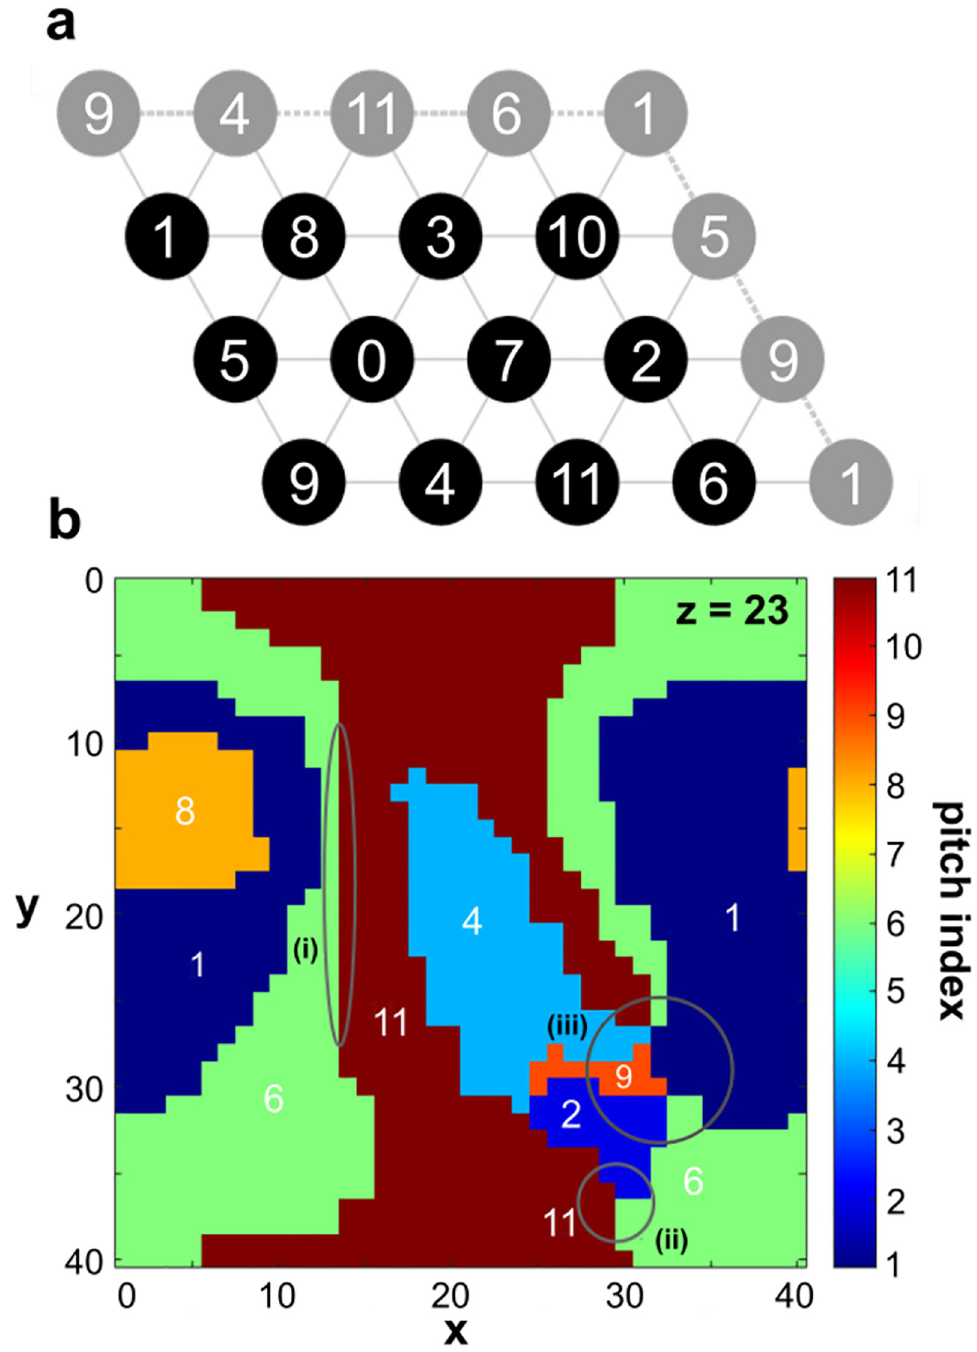
Fig 6. Arrangement of pitches in the quenched state. (a) The Tonnetz, with pitch indices labeling nodes and edges representing consonant intervals. Edges connecting nodes across the graph are indicated by repeated nodes shown in gray. (b) A 2D slice from the simulated 3D lattice at T = 5 D 0 following a quench at τ site, colored according to pitch. (i) shows a domain wall with an interval of p4 or p5, (ii) shows a minor triad vortex, (iii) encircles another triad vortex and two tetrad